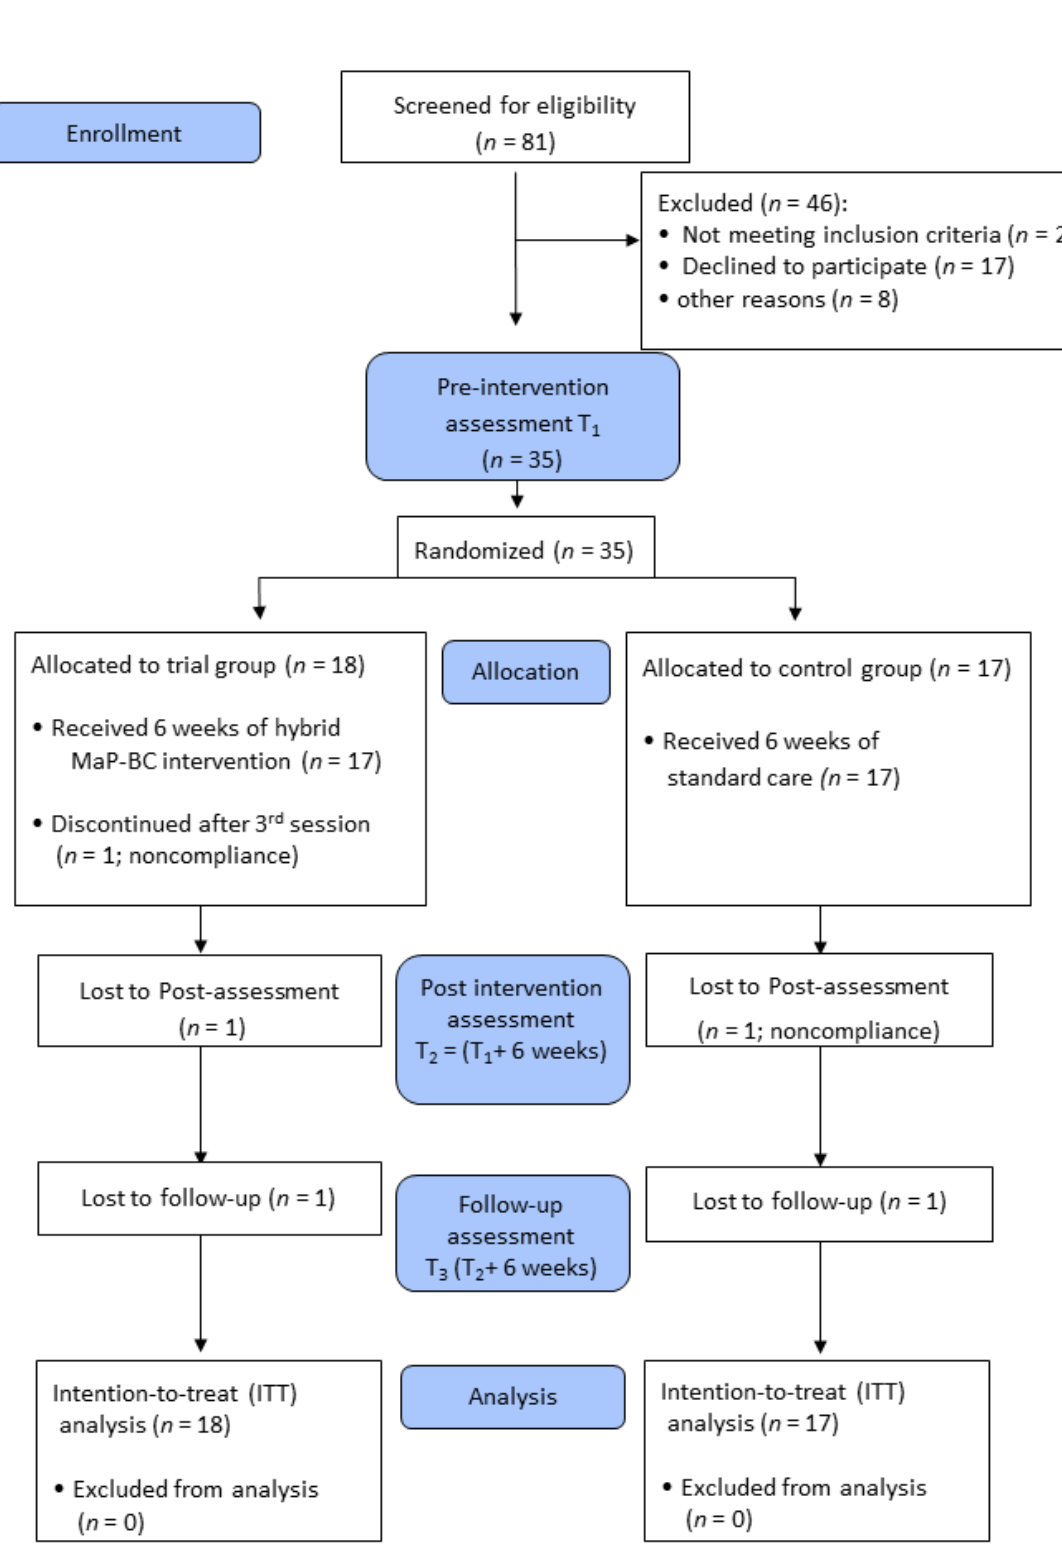
Figure 1. Randomized control trial CONSORT diagram of the study. Abbreviations: T1 = Time 1; T2 = Time 2; T3 = Time 3; MaP-BC = Managing Participation with Breast Cancer; ITT = Intention-To-Treat analysis.